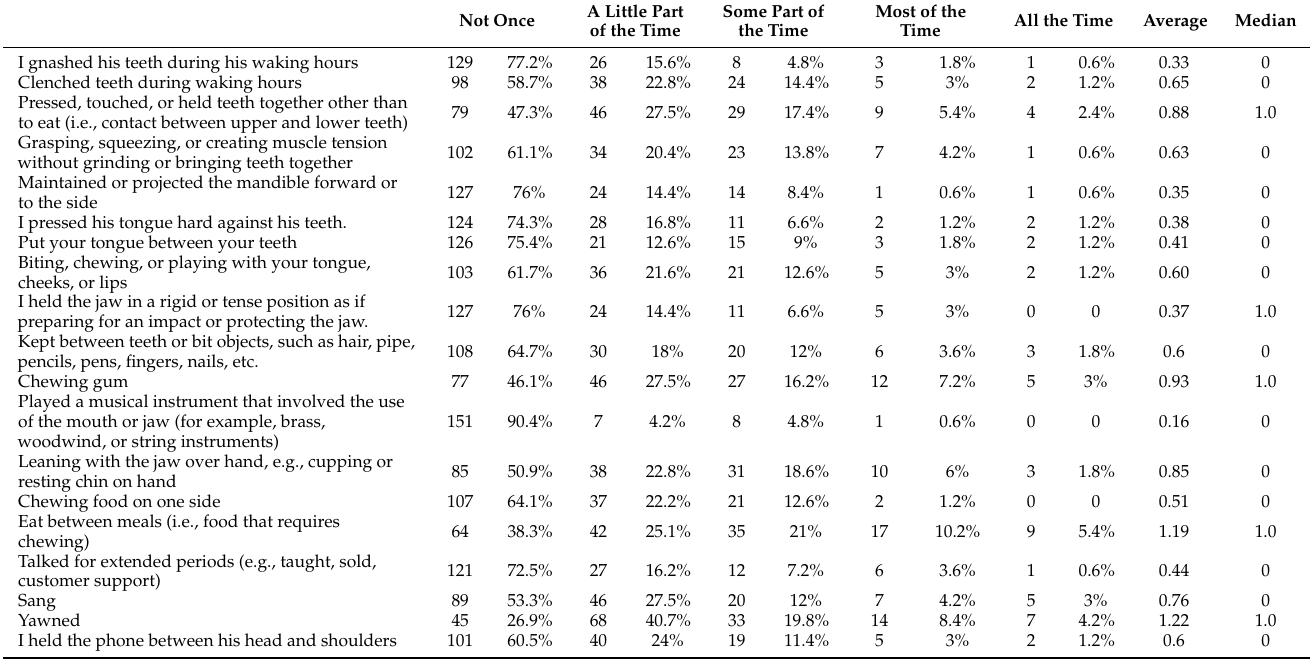
Table 5. Results related to OBs questions during the day.